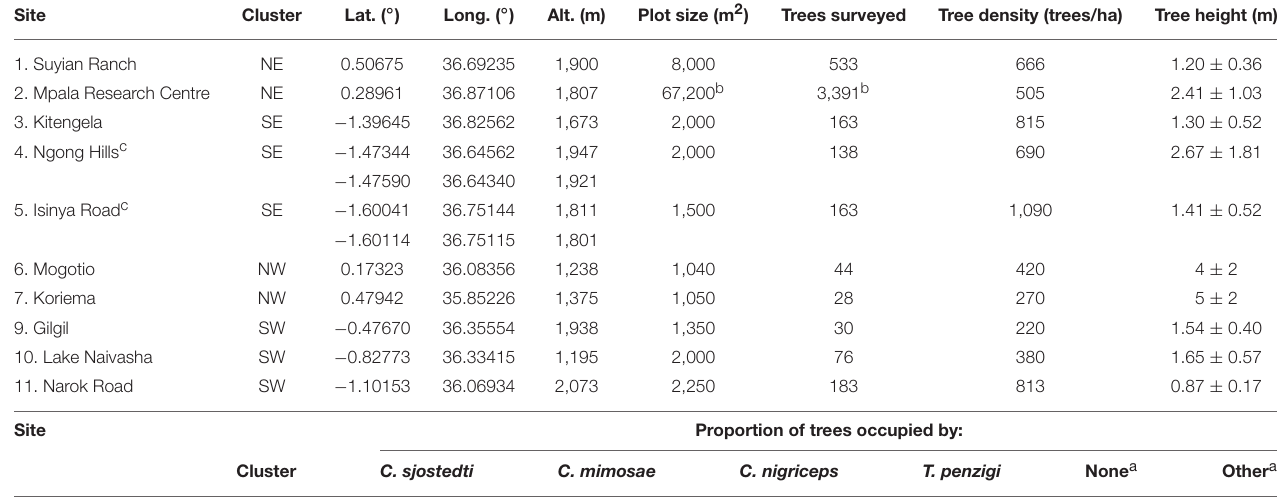
TABLE 1 | Demography of the V. drepanolobium -ant association varies throughout Kenya (survey data collected 2013–2016). Site Cluster Lat. ( ◦ ) Long. ( ◦ ) Alt. (m) Plot size (m 2 ) Trees surveyed Tree density (trees/ha) Tree height